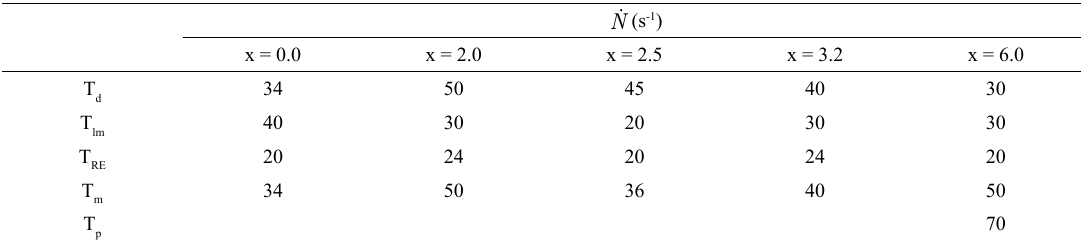
Figure 1. The plot of dielectric and acoustic emission data measured in Na dot: x =0.00; dash-dot: x =0.02; dot: x =0.025; dash: x =0.0325; solid: x =0.06). Table 1. Values of AE count rate , corresponding to T